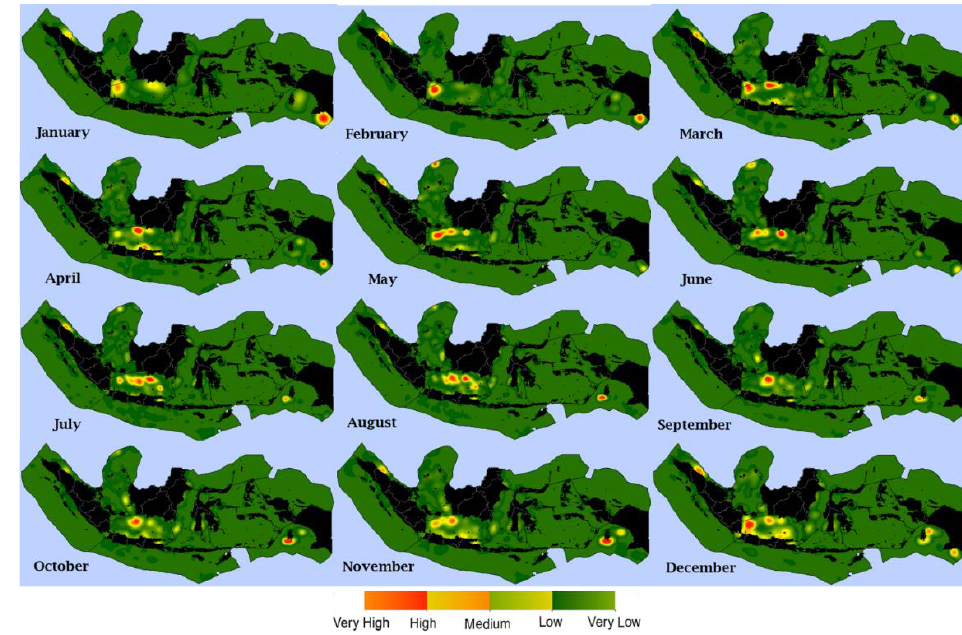
Figure 8. Monthly vessel activity zones in 2018. Figure 9 shows that the average ship activity in 2018 was concentrated only in WPP-RI 571, WPP-RI 711, WPP-RI 712, WPP-RI 713, and WPP-RI 718. In particular, medium–high VAZ was concentrated only in WPP-RI 571, WPP-RI 712, and WPP-RI